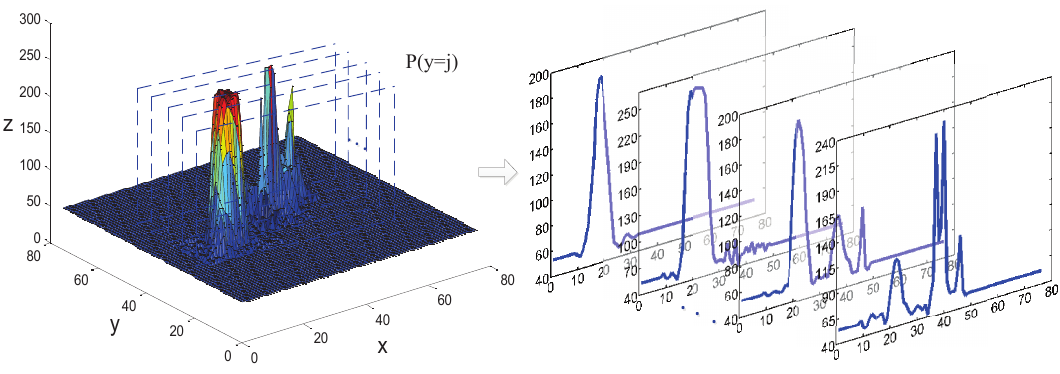
Figure 4. Extraction of image-surface profiles. Assuming the image surface is z ( x , y ) , and p ( y = j )